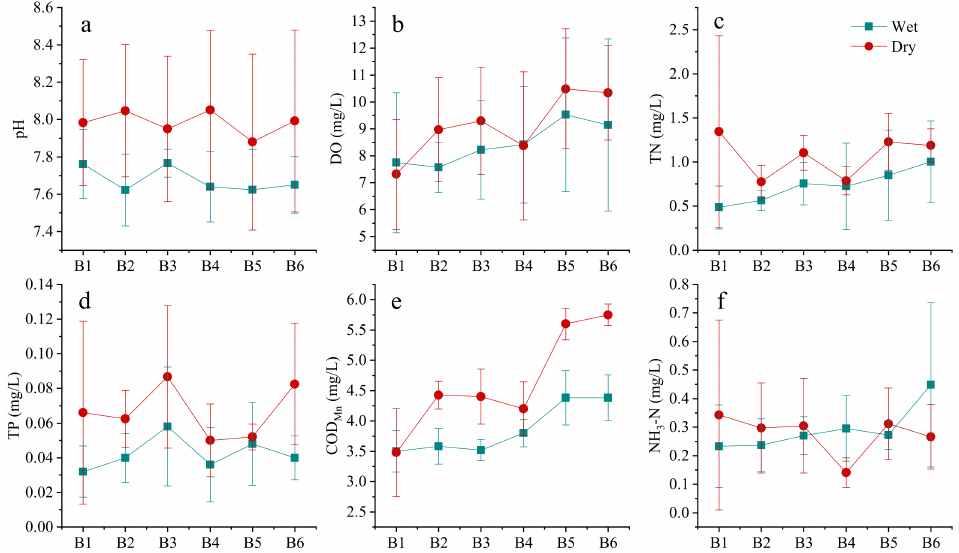
Figure 4. Distribution status of pH ( a ), DO ( b ), TN ( c ), TP ( d ), COD Mn ( e ) and NH 3 -N ( f ) for Baoan Lake and Sanshan Lake during the dry and wet seasons. In this figure, B1–B4 are the sampling points in Baoan Lake, and B5–B6 are the sampling points in Sanshan